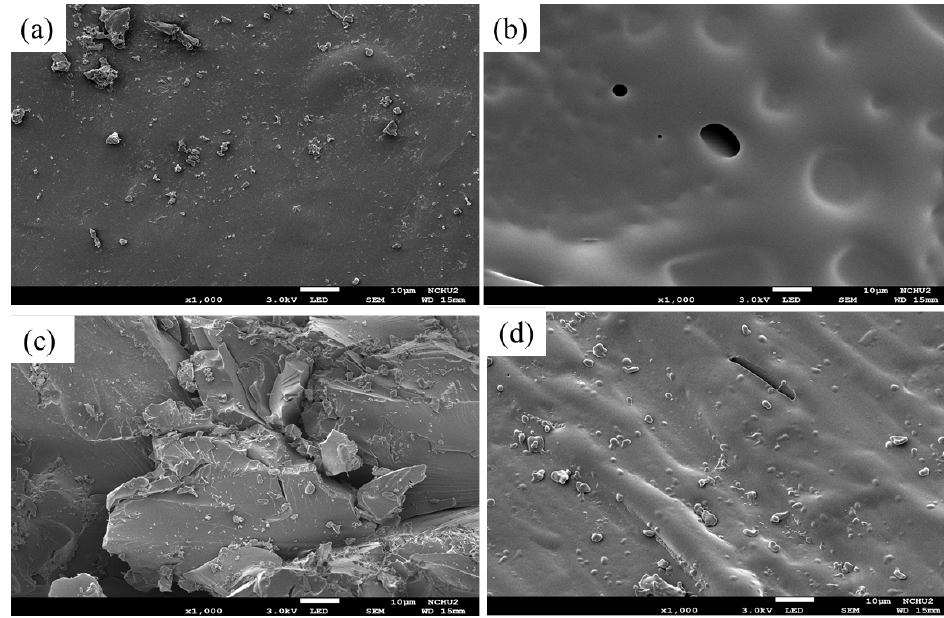
Figure 5. SEM micrographs of composites ( a ) Epoxy/Bagasse@ TGIC@DOPO IPN 5% (before burning) ( × 1K); ( b ) Epoxy/Bagasse@TGIC@DOPO IPN 5% (after burning) ( × 1K); ( c ) Epoxy/Bagasse@TGIC@DOPO IPN 30% (before burning) ( × 1K); ( d ) Epoxy /Bagasse@TGIC@DOPO IPN 30% (after burning) ( ×